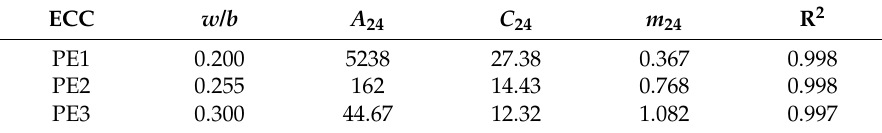
Table 10. Regression coefficients at f = 2.4 GHz and goodness of fits for Equation